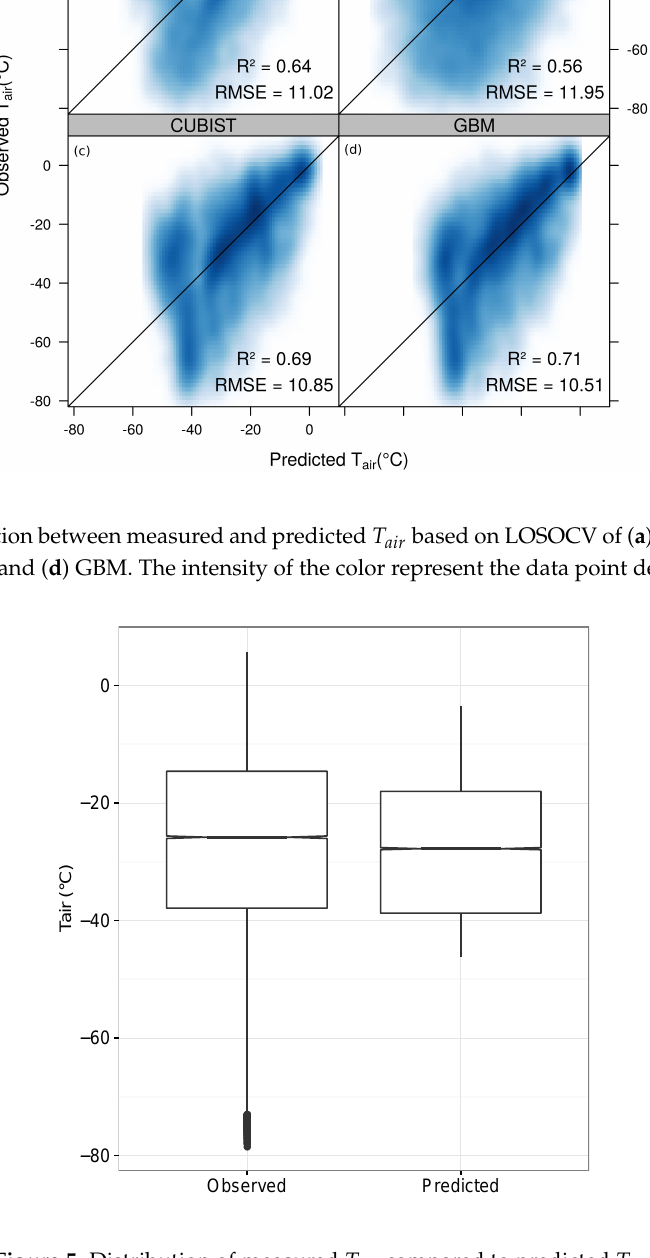
Figure 5. Distribution of measured T air compared to predicted T air